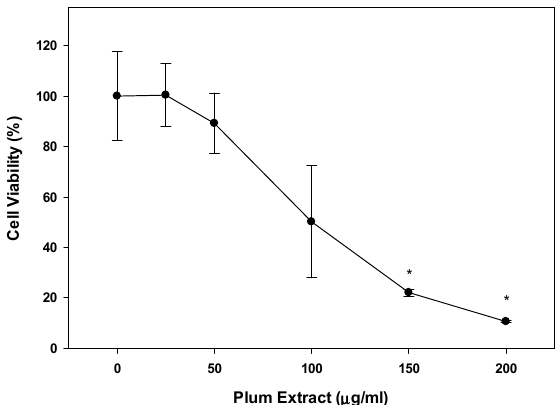
Figure 7. Effect of plum extract on Colon-26 adenocarcinoma cells. Data were calculated as % inhibition of cell growth in response to various concentrations of plum extract. The data are expressed as mean ± SD for at least three replicates. All comparisons were made to control (untreated cells) using one-way ANOVA; the significant differences are reported at * p < 0.05. 3.8. Effect of PE60 Plum Extract on C2C12 Cell Viability in Response to Colon-26 Cells Cytotoxicity-Inducing